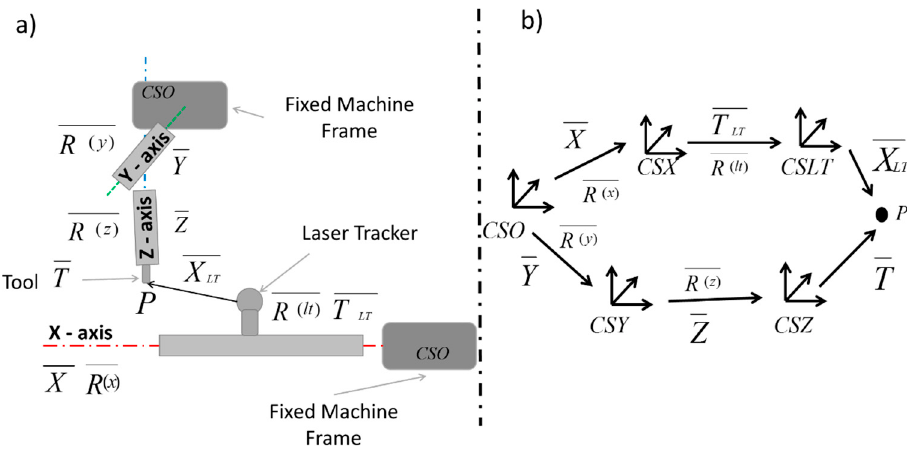
Figure 2. ( a ) Layout of measuring system in a MT with XFYZ configuration. ( b ) Kinematic scheme of a Figure 2. a ) Layout of measuring system in a MT with XFYZ configuration. b ) Kinematic scheme of a MT with XFYZ MT with XFYZ configuration